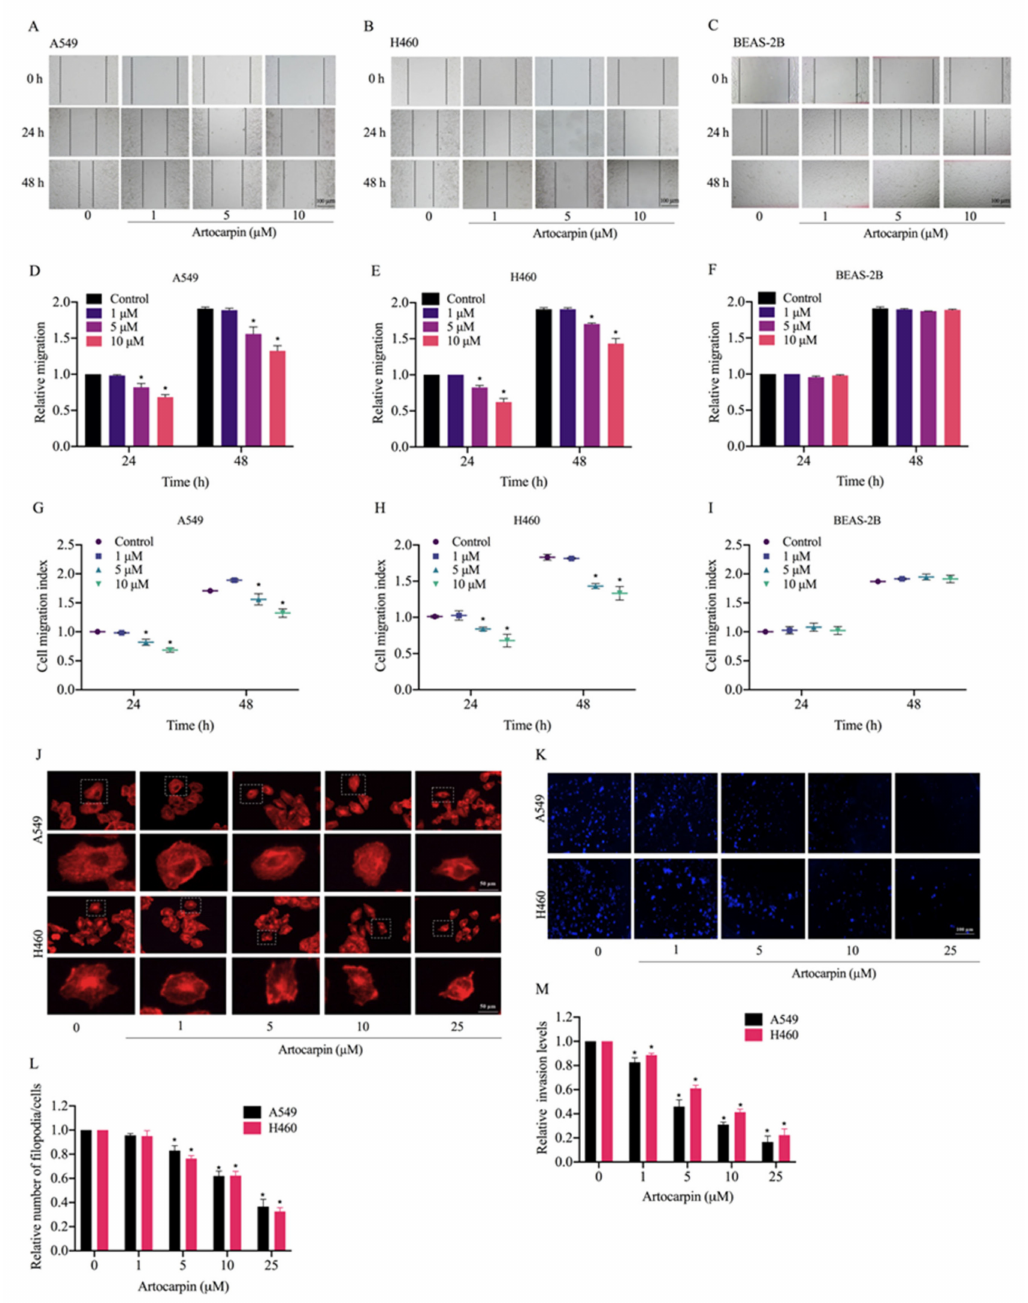
Figure 2. Effect of artocarpin on cancer cell migration, filopodia formation, and invasion. ( A , B ) Artocarpin decreased A549 and H460 cell migration but not BEAS-2B cell migration: Cells were treated with non-toxic doses of artocarpin (0–10 µ M), and cell migrations at 24 and 48 h were determined. ( C ) Artocarpin at concentrations of 0–10 µ M had no effect on cell migration of BEAS-2B cells at 24 h. ( D – F ) The relative cell migration of the treated cells was determined, and ( G – I ) cell migration index was calculated by normalizing with the proliferation index. ( J , L ) Effect of artocarpin on filopodia formation. The artocarpin-treated cells were stained with phalloidin-rhodamine and the filopodia was visualized by fluorescent microscopy. Relative number of filopodia per cell in A549 and H460 cells treated with artocarpin, compared with the control. ( K , M ) A549 and H460 cell invasion was examined using transwell invasion assay. The relative cell migration and invasion were calculated by compared to control. After 24 h, the invaded cells were stained with Hoechst 33342 and determined using fluorescence microscopy. Data represent the mean ± SD ( n = 3). * p < 0.05 versus non-treated